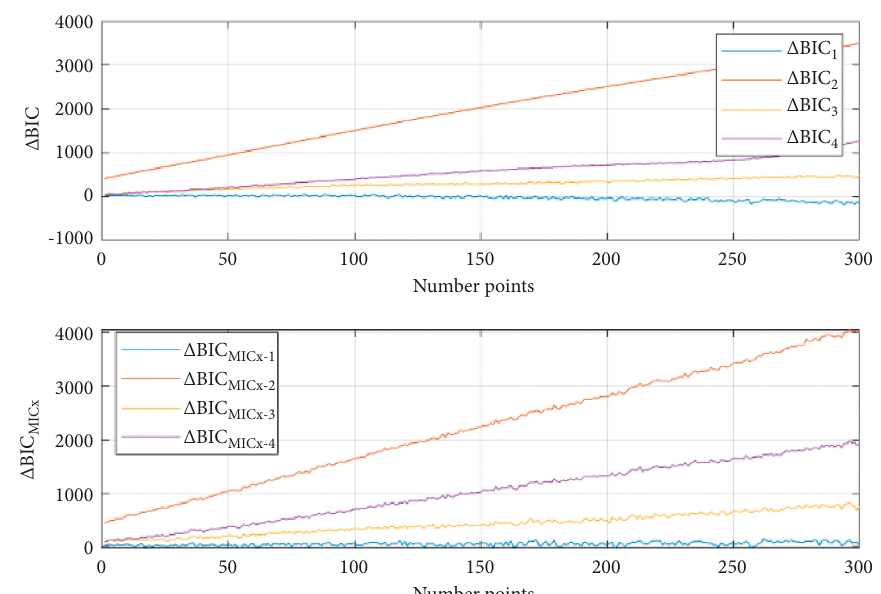
Figure 9: Comparison of the traditional BIC with the new BIC MICx vs. the number of points for the models of Table 1 in Section 3. The plots show the indicator difference between the candidate models and the reference one; therefore negative values indicate that the corresponding indicator would have reached the wrong conclusion about the model to